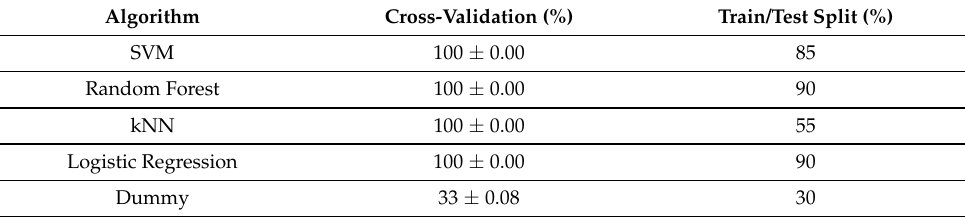
Table 4. Classification results for TF-IDF feature extraction with handcrafted features when using 10-fold cross validation and on unseen data